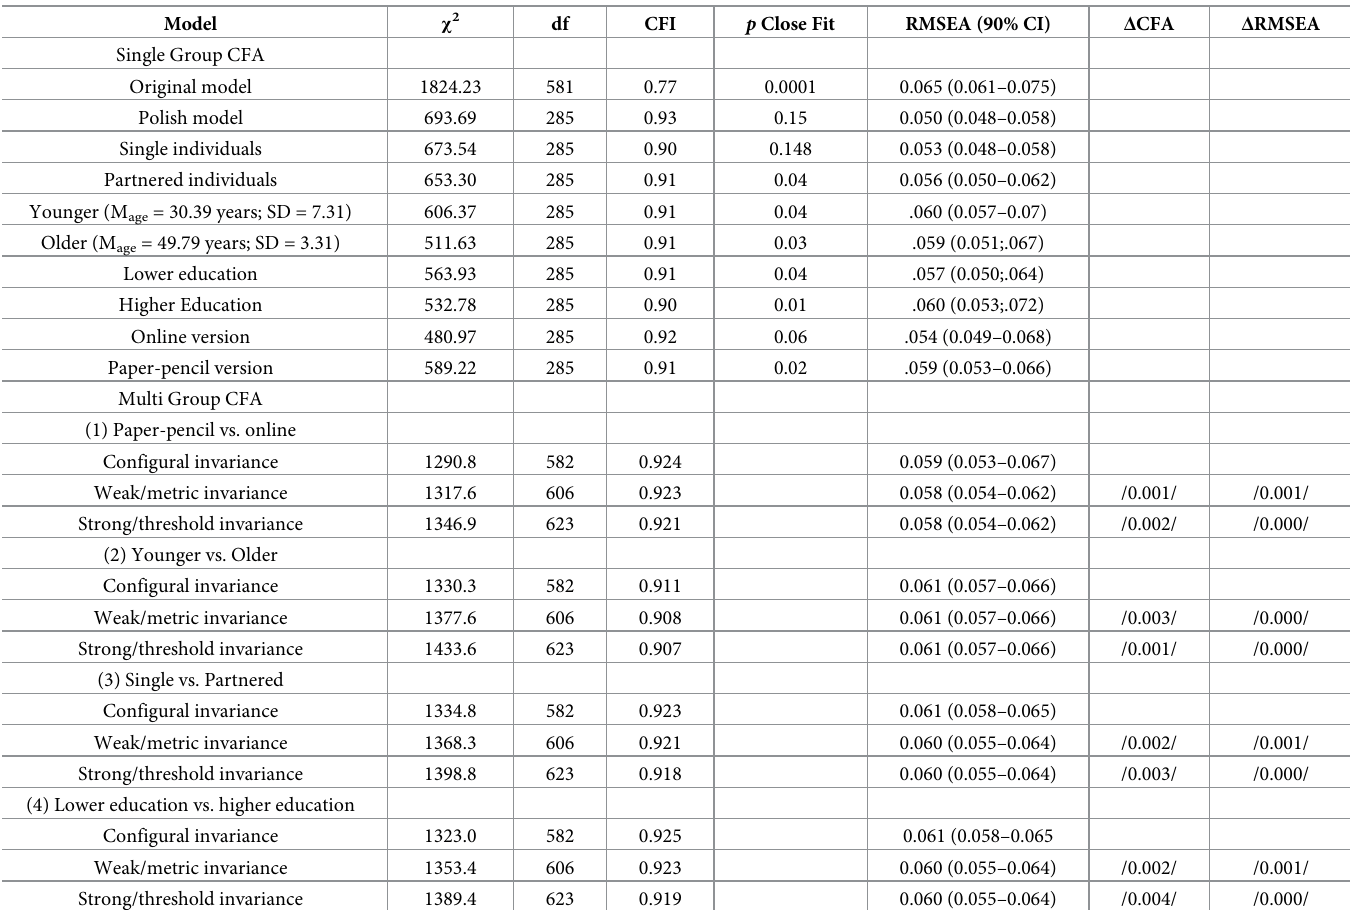
Table 2. Model fit indices for different model and different